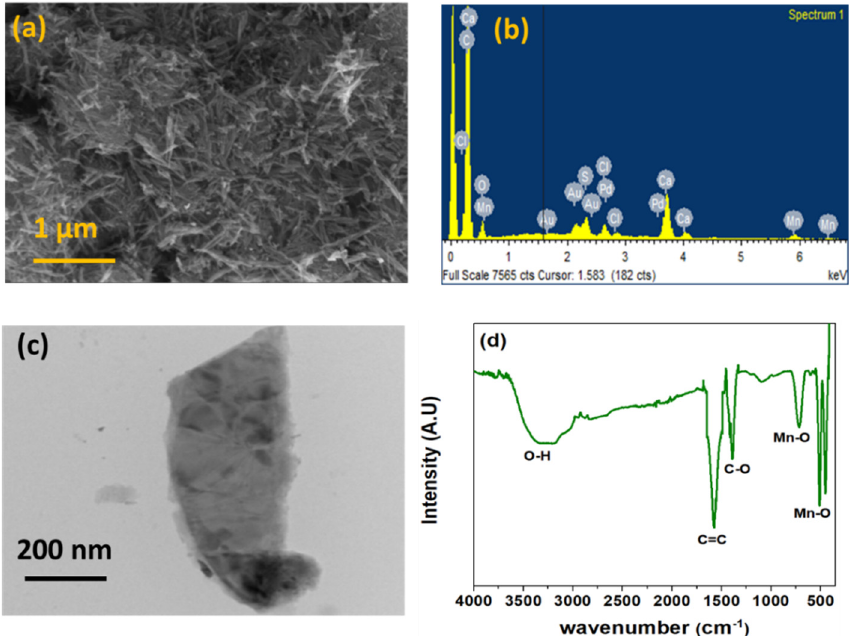
Figure 2. ( a ) SEM micrograph recorded at 20 keV; ( b ) EDX spectrum; ( c ) TEM image obtained at 120 keV; ( d ) FTIR spectrum obtained within 4000–500 cm − 1 of α -MnO 2 /GQD nanocomposites.